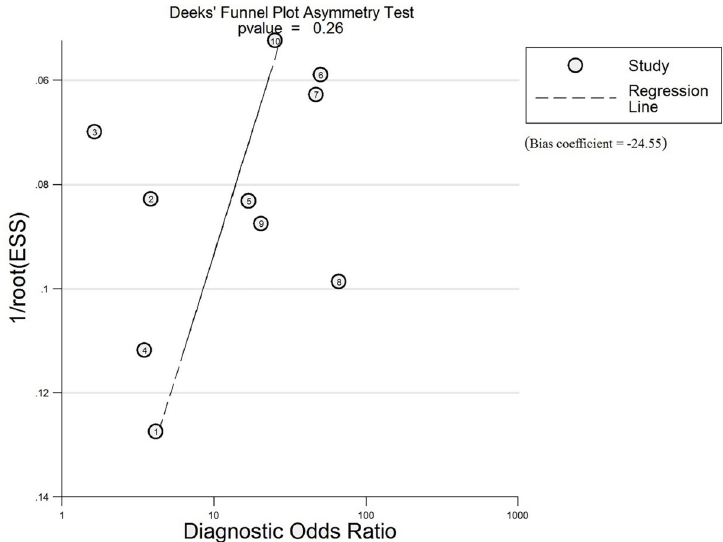
Fig 2. Results of Deeks’ funnel plot asymmetry test for the evaluation of potential publication bias. Every point represents one study and the line is the regression line. The nonsignificant slope indicates that no significant bias was found. The p value is of 0.26 (Bias coefficient =